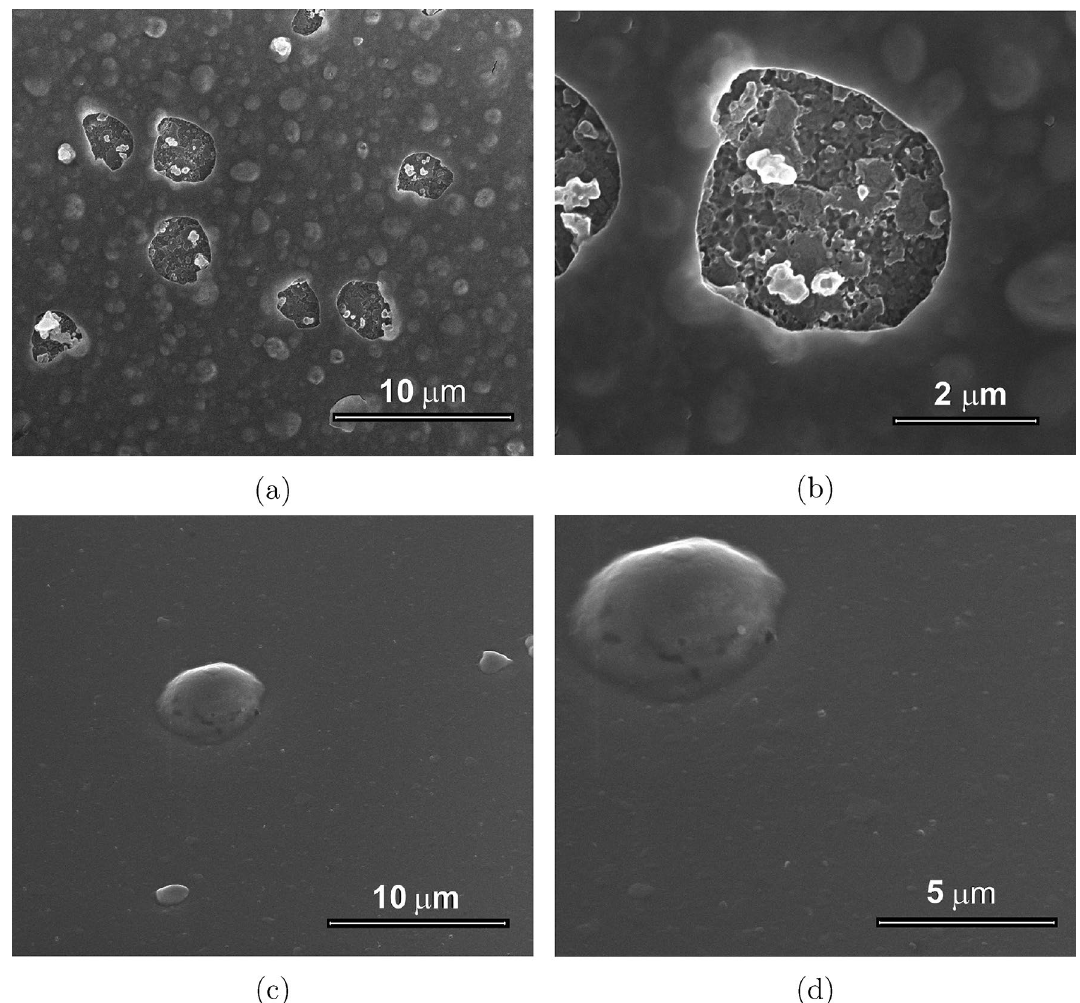
Figure 7. SEM images of the samples irradiated with 16 keV ( a , b ) and 100 keV ( c , d ) He ions.